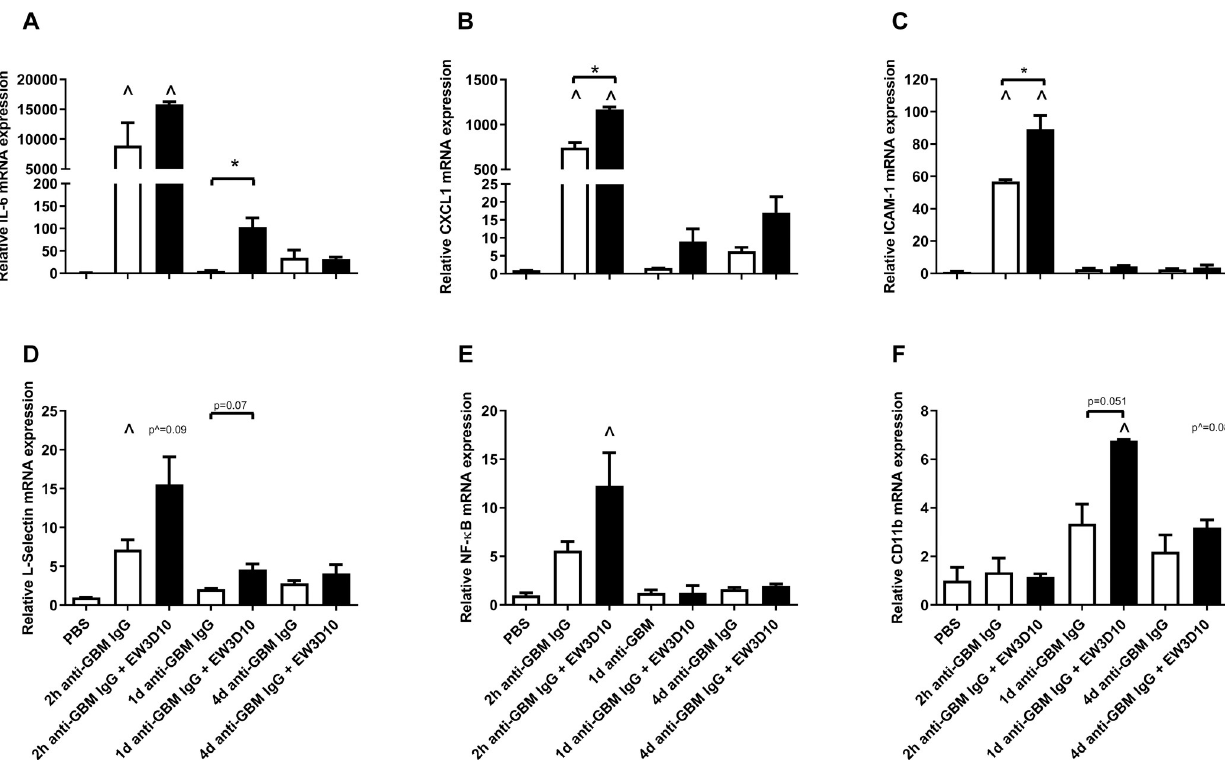
Fig 5. mRNA expression of pro-inflammatory mediators is increased after co-injection of anti-HS antibody EW3D10 in anti-GBM-induced glomerulonephritis. mRNA expression of (A) IL-6, (B) CXCL1, (C) ICAM-1, (D) L-selectin, (E) NF-B, (F) CD11b in renal cortex from anti-GBM IgG- or EW3D10-co-injected mice after 2 hours, 1 day and 4 days. Graphs show the relative mRNA expression in experimental mice compared to PBS-treated mice, using GAPDH as the housekeeping gene. Results are expressed as means ± s.e.m. ^ P < 0.05 vs. PBS-injected mice. � P < 0.05 between 2 groups.